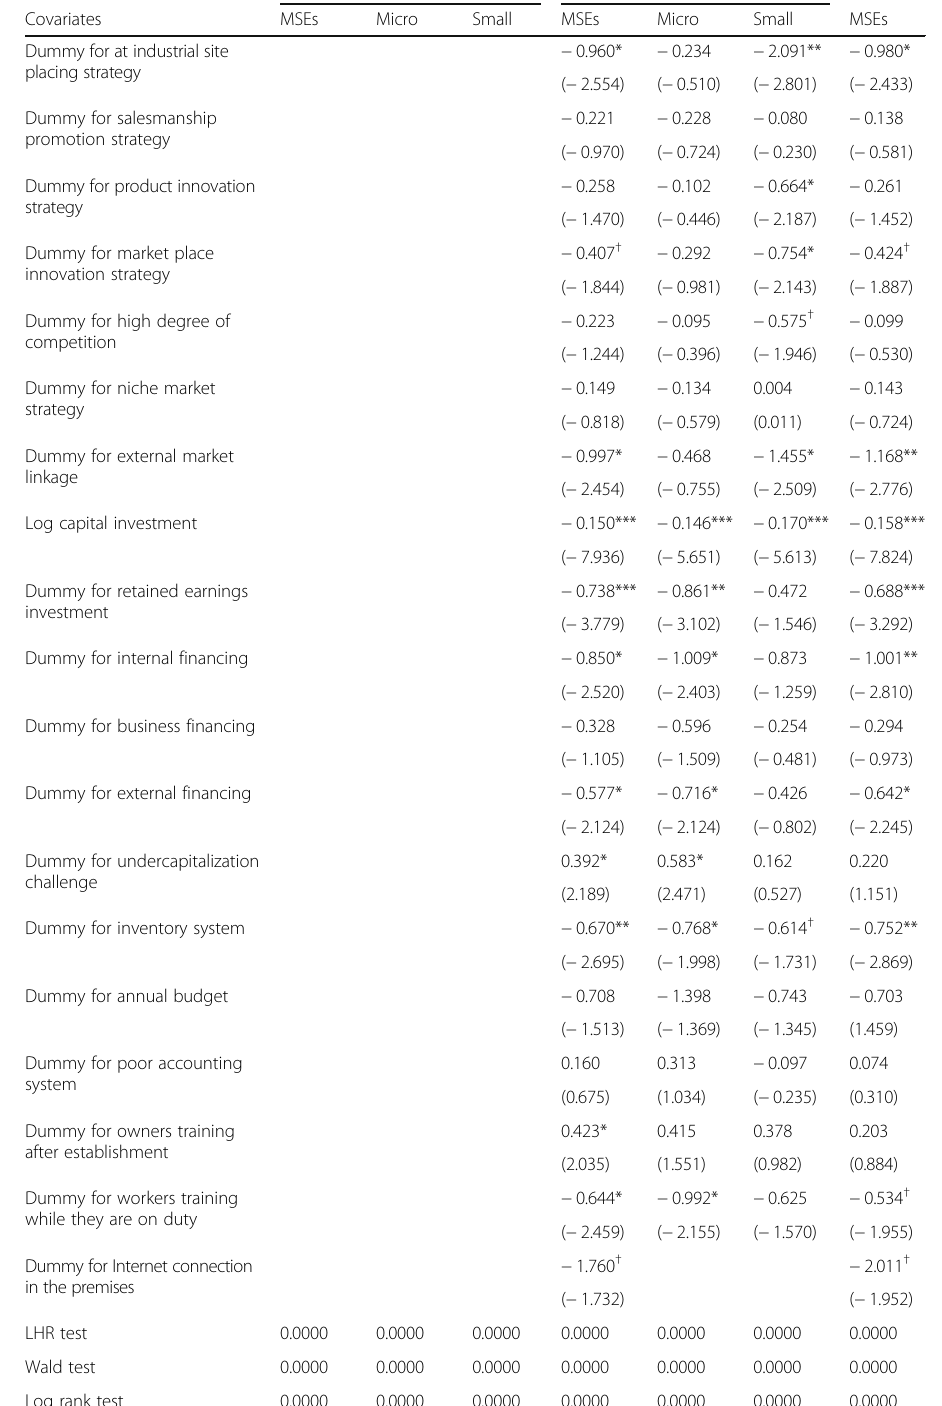
Table 3 Partial likelihood estimates for the Cox proportional hazard models